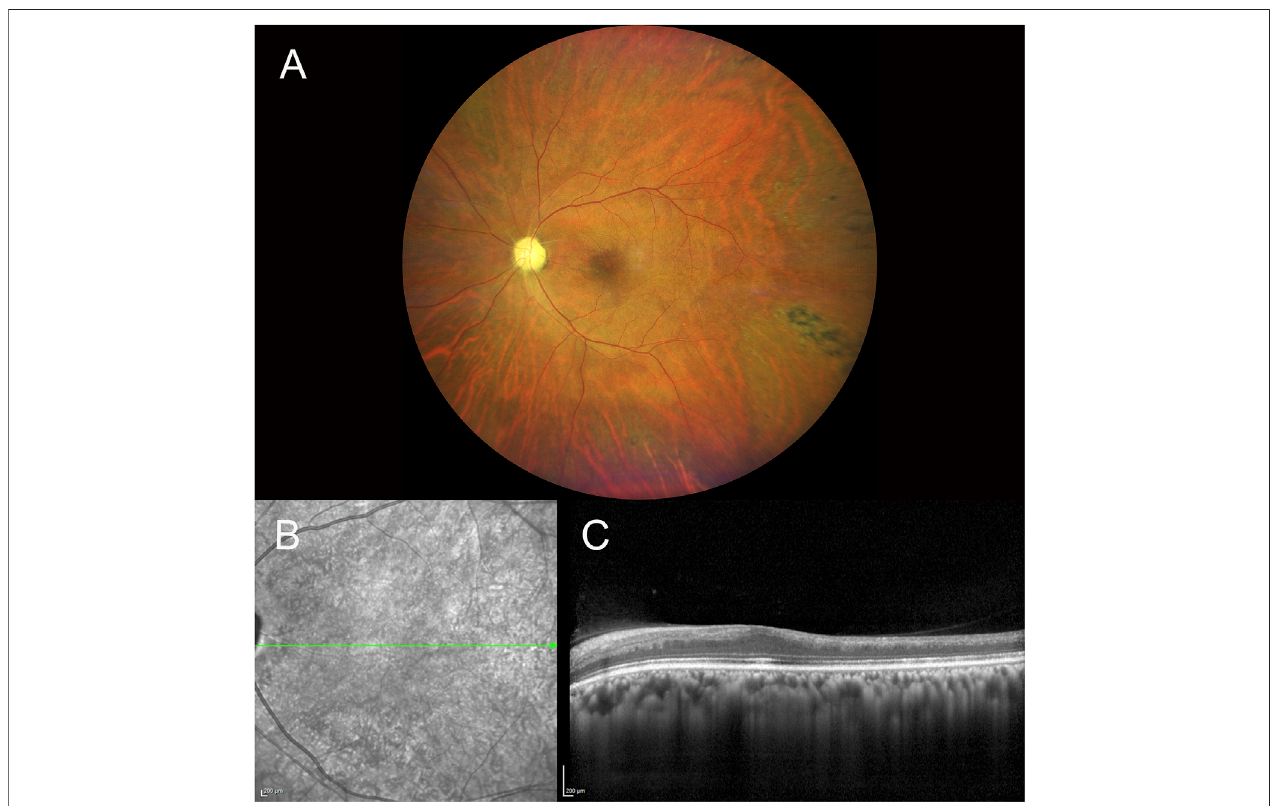
FIGURE1| Fundusphotographyofthelefteyeshowingthepresenceofapaleopticdisc,diffusearterialnarrowing,amild ‘ cherry-redspot ’ macula andperipheral areas of retinal pigmented epithelium hyperpigmentation (A) . IR and SD-OCT acquisition over the macular region of the same eye denoting atrophy of the inner retina layers with loss of foveal depression and temporal macular thinning (B,C) [IR, infrared re fl ectance, SD-OCT, spectral domain optical coherence tomography ].